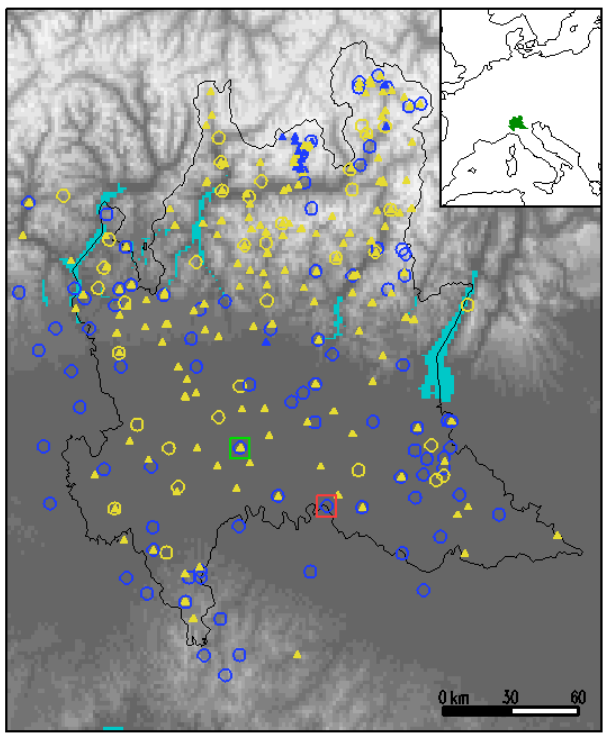
Fig. 1. Observing stations providing rainfall annual maxima in Lombardy’s orography. Lakes are shaded in cyan. The black line shows the administrative boundary. Circles: “mechanical” stations; triangle: “automatic” stations. Yellow: less than 10 observations; blue: more than 10 observations. The inset shows the geographical position of Lombardy. The squares mark the stations discussed in Sect. 3: LODI, green, and CREMONA,